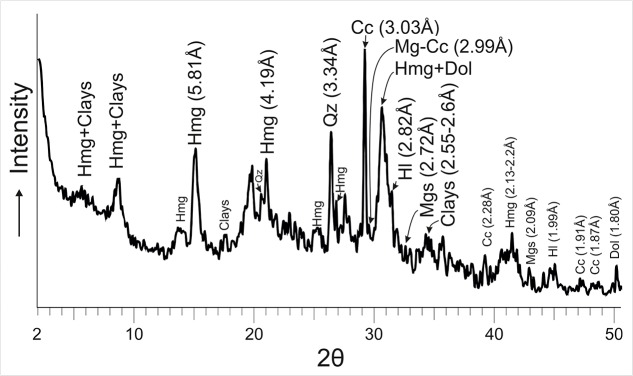
XRD showing the peaks of hydromagnesite-dypingite assemblage (Hmg), dolomite (Dol), magnesite (Mgs) and magnesian-calcite (Mg-Cc) as main authigenic Mg-carbonates of the microbialite. The other peaks correspond to Quartz (Qz), Calcite (Cc) and clays. Patterns used from the PDF2 database were: Hydromagnesite = 00-025-0513, Dypingite = 00-023-1218, Mica (clays) = 01-070-1869, Cc = 01-083-1762, Qz = 01-079-1910, Dol = 01-074-1687, Mgs = 01-086-2344, Mg-Cc = 01-086-2336, Hl = 01-075-0306.